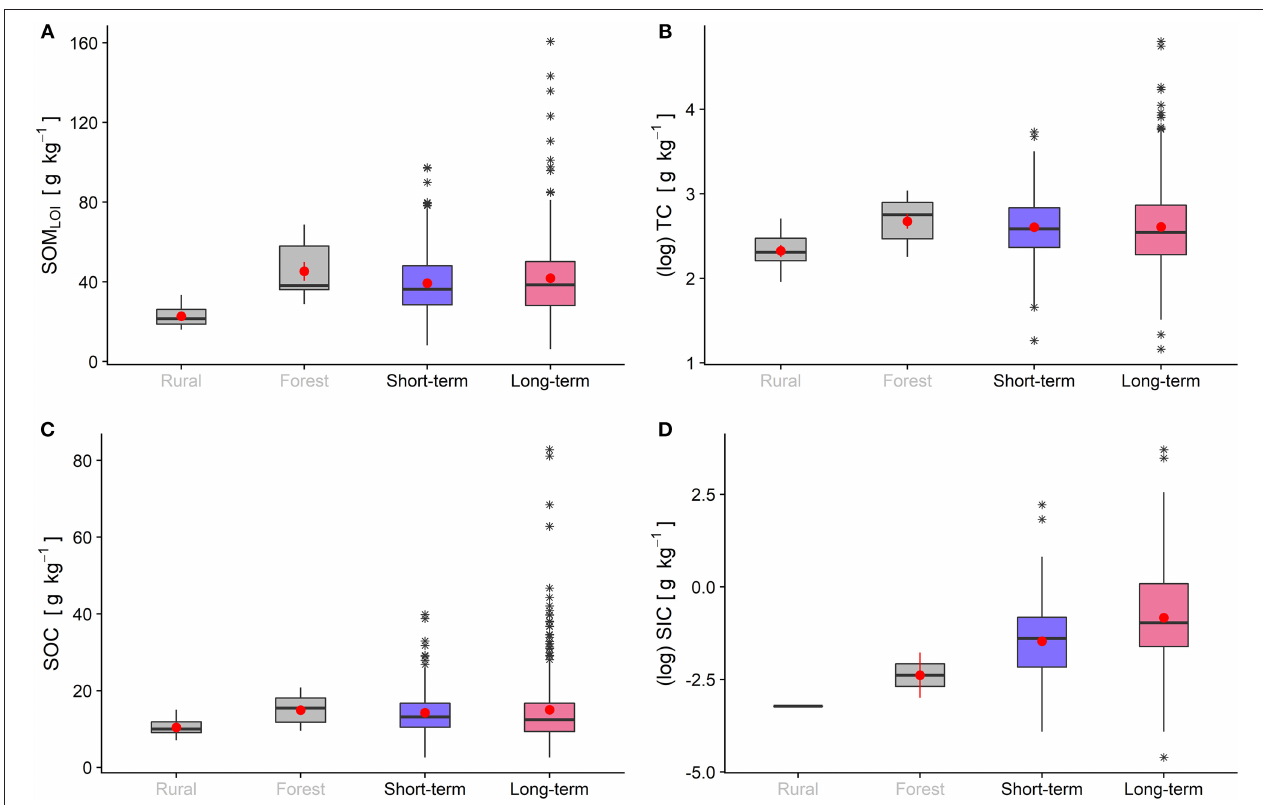
FIGURE 7 | Boxplots comparing rural, forest and urban soils with respect to bulk soil contents of (A) SOM LOI , soil organic matter obtained from loss on ignition; (B) TC, total carbon; (C) SOC, soil organic carbon; (D) SIC, soil inorganic carbon. Arithmetic means (red points), standard errors (red whiskers), medians (bars), ranges (whiskers), and outliers (asterisks) are